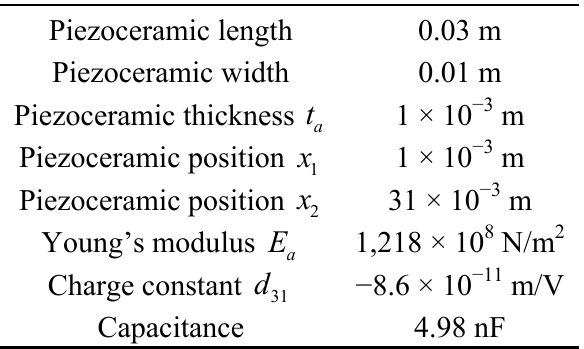
Table 1. Parameters of the piezoceramic